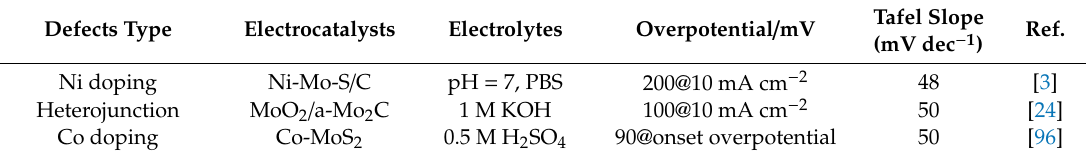
Comparison of hydrogen evolution reaction (HER) performances of Mo-based defect